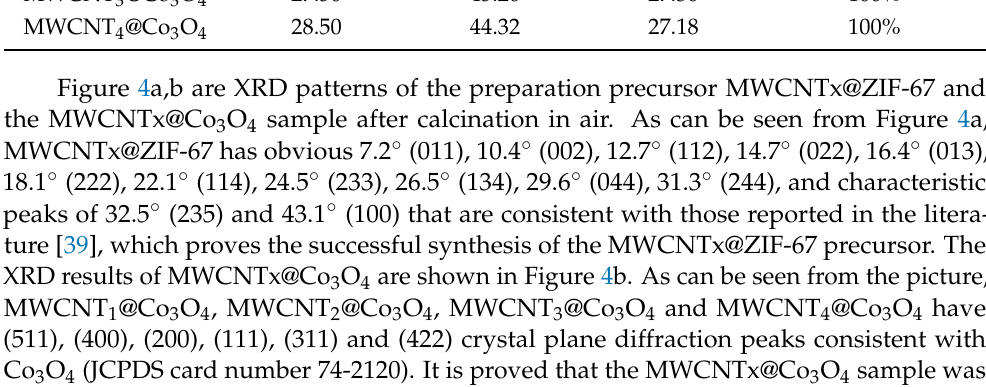
Figure 4a,b are XRD patterns of the preparation precursor MWCNTx@ZIF-67